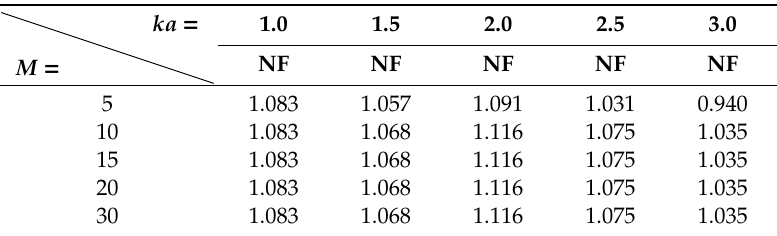
Table 2. Variation of the normalized mean drift wave force on the exterior porous shell, f − s , with respect to M ( d = 3 a , b = 2 a , and G 0 = 0.1).